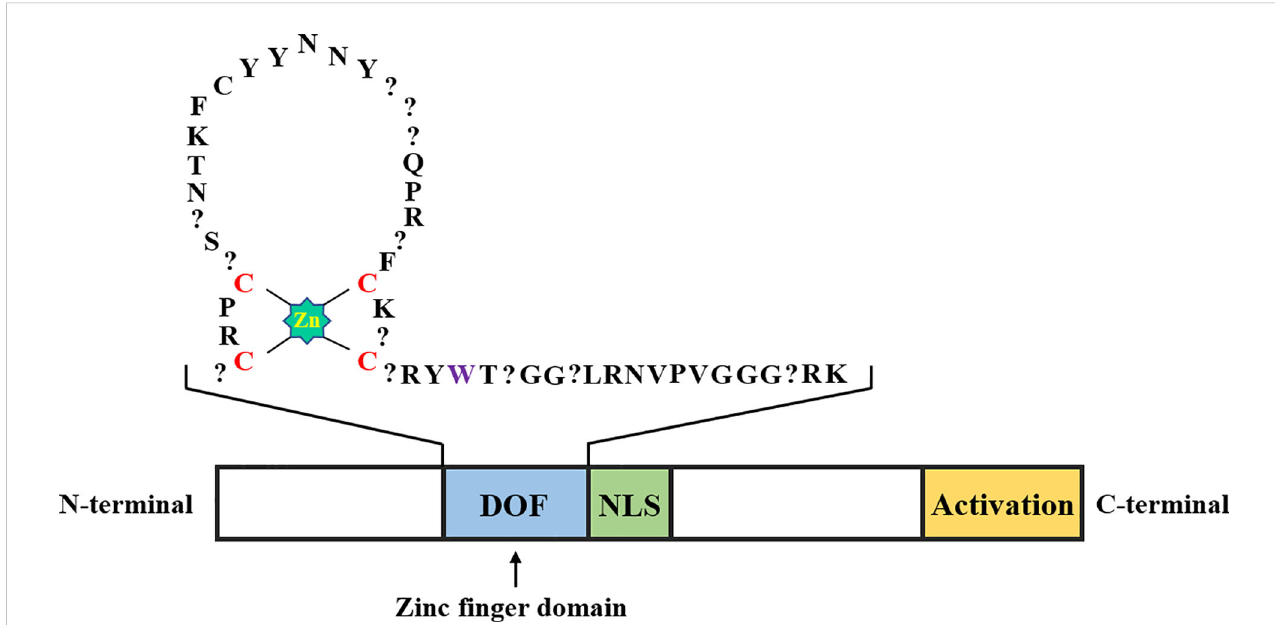
FIGURE 1 Schematic representation of the DOF transcription factor structure. The DOF zinc fi nger domain, nuclear localization signal, and transcriptional activation domain are shown in blue, green, and yellow, respectively. The amino acid sequence in the zinc fi nger domain of DOF is represented by abbreviations, the zinc coordination is shown in bright green, the position of the four cysteines in the zinc fi nger structure is shown in red, the question mark represents any amino acid, and the tryptophan residue mentioned in the second part is shown in